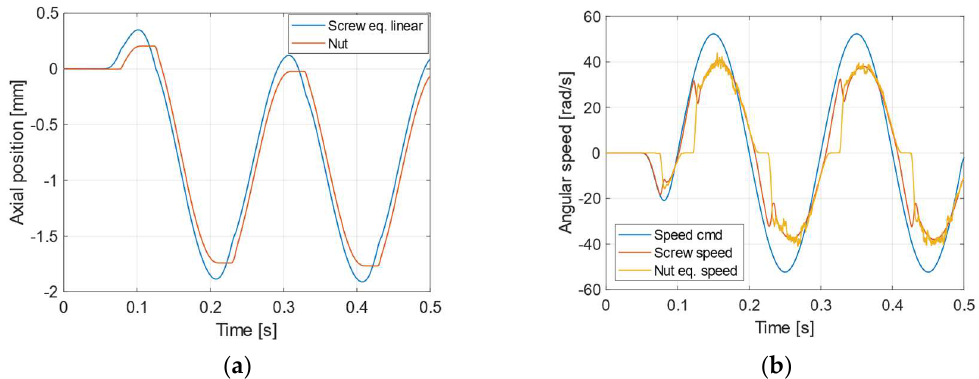
Figure 8. Simulation results of a ball screw with a high backlash of 0.3 mm. ( a ) Comparison between the nut position and the equivalent linear position of the screw shaft; ( b ) Comparison between the equivalent angular speeds of the screw shaft and the nut (© 2020 ASME. Reprinted, with permission, from [33]).